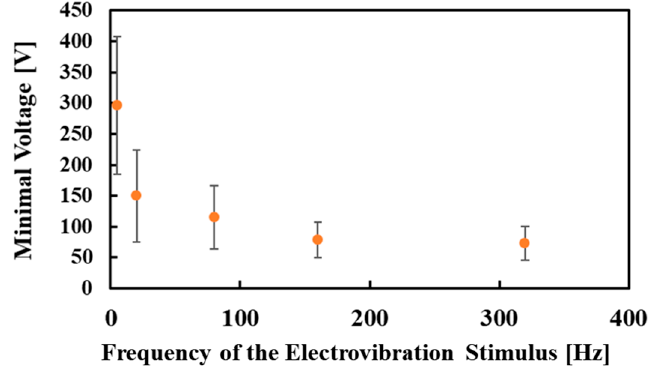
Figure 7. The relationship between the frequency of the electrovibration stimulus and the minimal voltage. The minimal voltage decreased with a decrease in the frequency. The trend was similar to the reported trends.